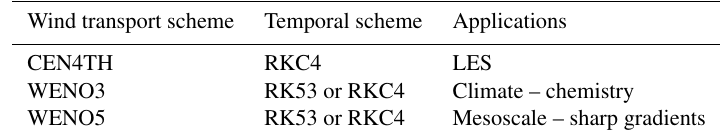
Figure 3. Representation of the time marching in Meso-NH with (a) WENO5/RKC4 and (b) CEN4TH/RKC4 for the momentum transport. Table 1. Recommendations for the choice of wind transport and temporal schemes according to the applications.